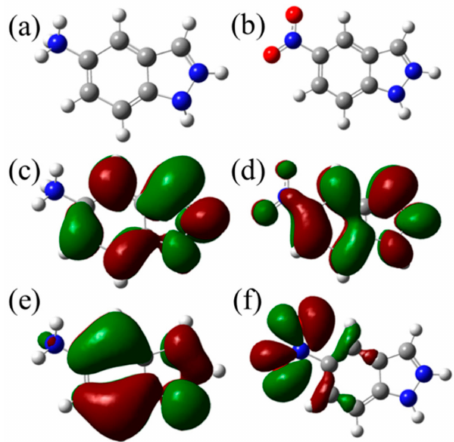
Figure 6. ( a , b ) Optimized geometric structures, ( c , d ) LUMO orbitals and ( e , f ) HOMO orbitals of AIA and NIA inhibitors. Table 3. Quantum chemical parameters for AIA and NIA by using the B3LYP / 6-311 + + G(d,p) method. Inhibitor E HOMO (eV) E LUMO